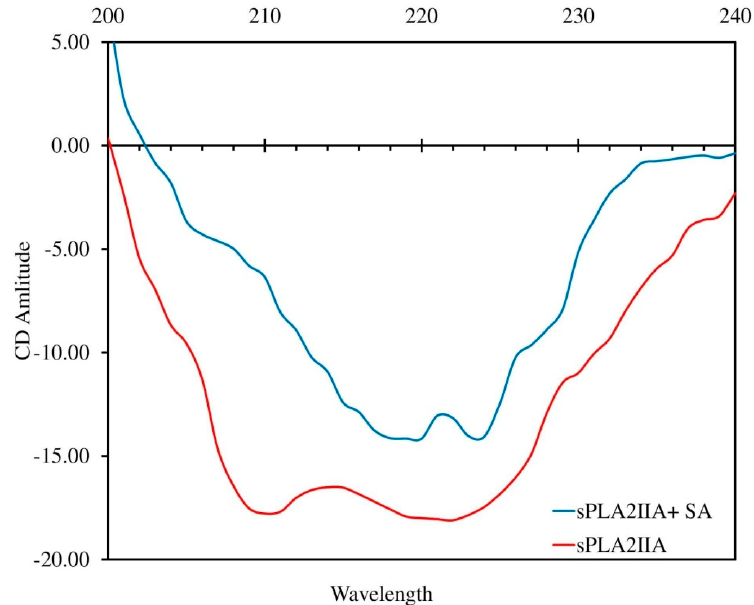
Figure 8. Circular Dichroism spectra of sPLA2-IIA with and without sinapic acid: The far-UV CD spectra of sPLA 2 -IIA alone (red line) and with sinapic acid (IC 50 concentration) (blue line) were recorded between 200 and 240 nm using a Jasco J-810 spectropolarimeter. Table 4. Secondary structure of sPLA 2 -IIA enzyme upon addition of sinapic acid.